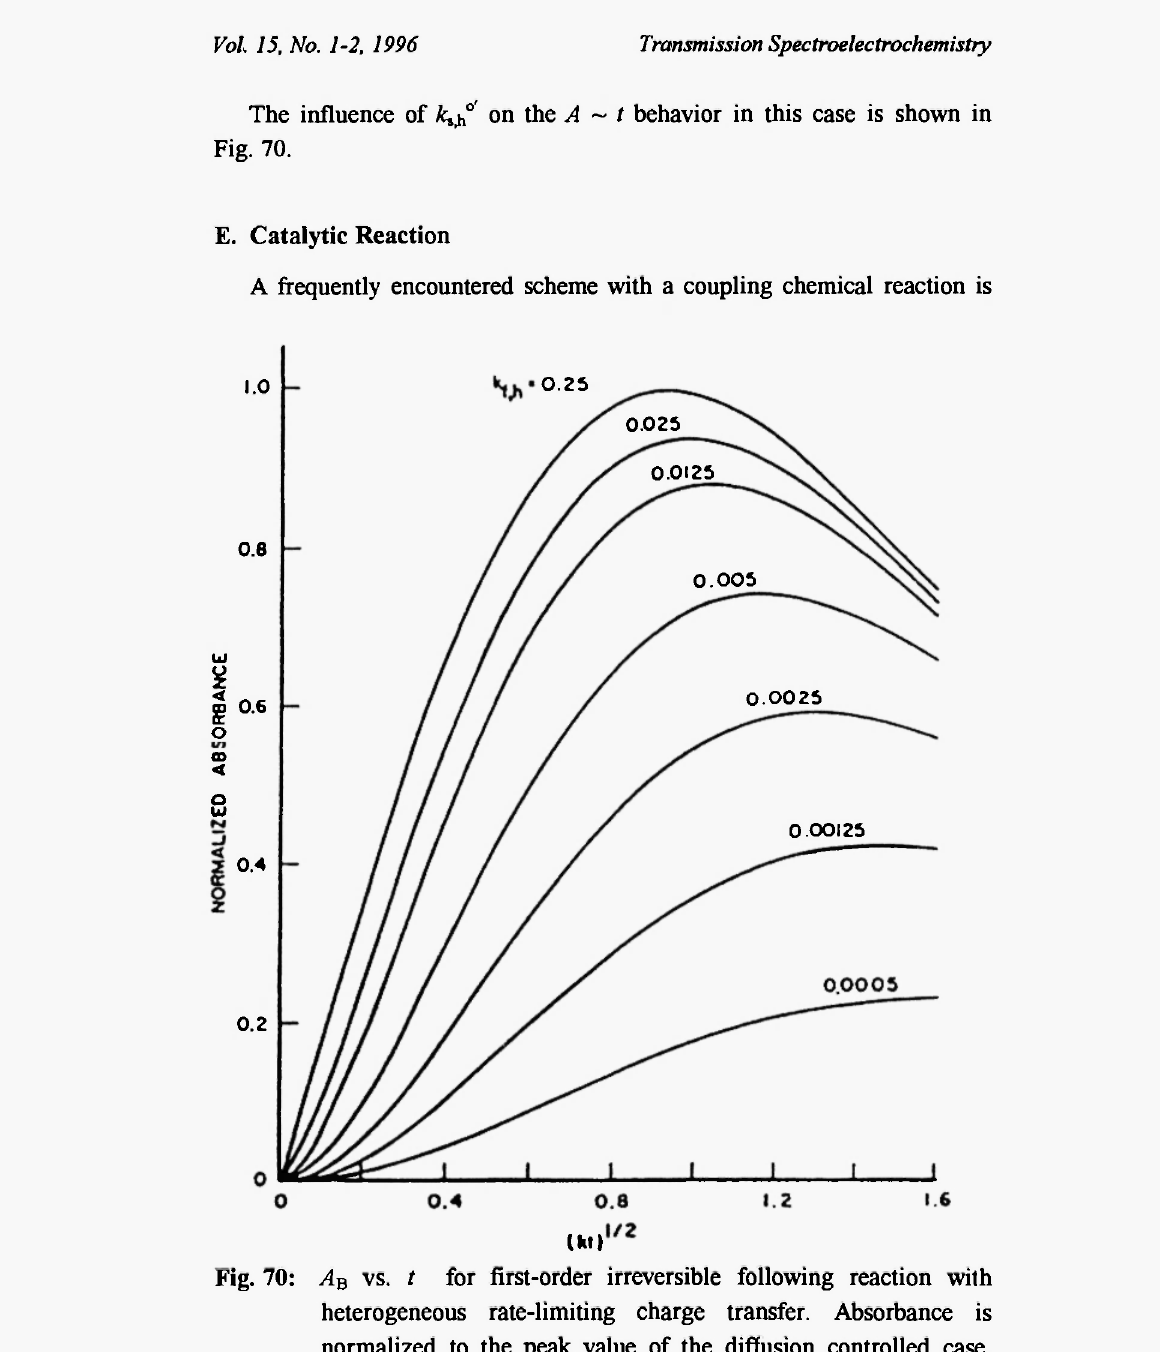
Fig. 70: Α VS. t for first-order irreversible following reaction with Β heterogeneous rate-limiting charge transfer. Absorbance is normalized to the peak value of the diffusion controlled case. (From Ref.